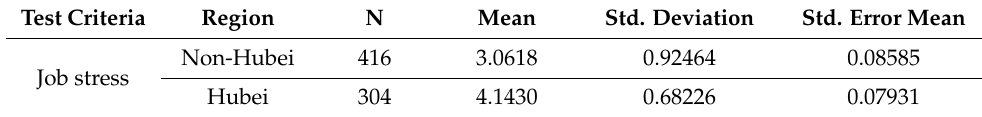
Table 6. The descriptive statistics for job stress in Hubei and non-Hubei regions.